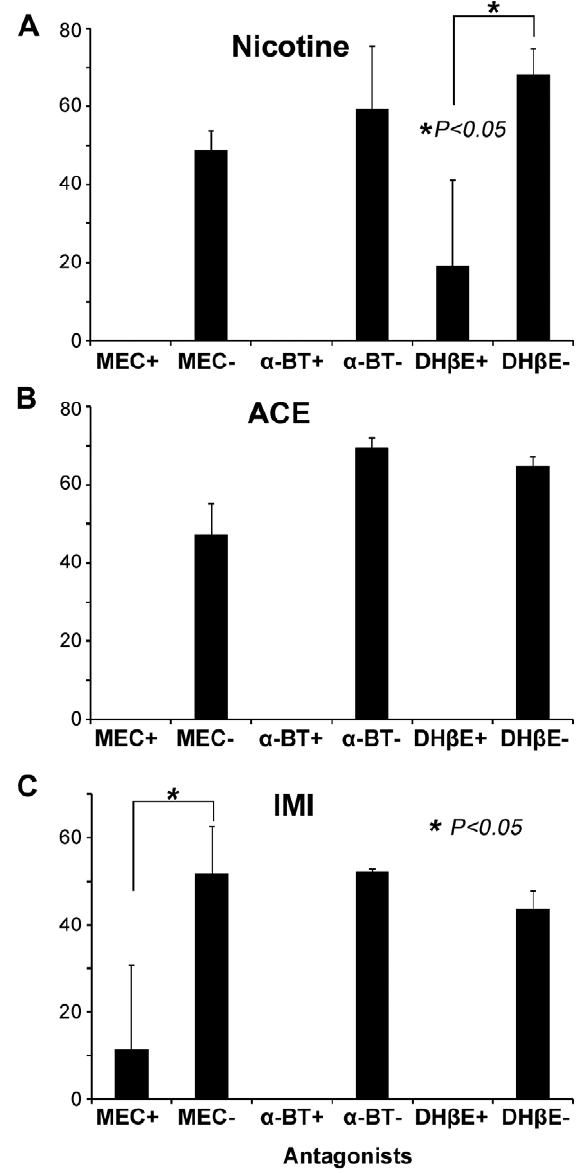
Figure 7. Effects of nAChR antagonists on the proportions of excited neurons. The proportions of the neurons excited by nicotine ( A ), ACE ( B ), or IMI ( C ) at 100 m M were compared in the presence or absence of MEC (100 m M), a -BT (1 m M), or DH b E (1 m M). All three antagonists significantly reduced the proportion of the cells that were excited by the agonists. The data represent the mean 6 the S.E.M. of three independent experiments and were analyzed using an ANOVA followed by a post hoc Bonferroni/Dunn